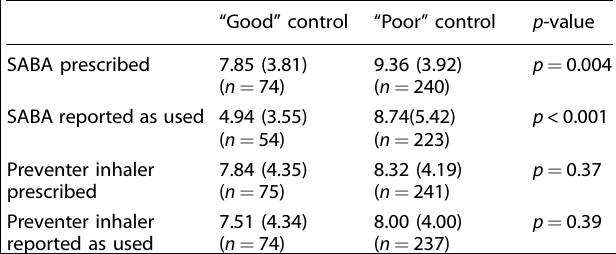
Table 3. Relationship between CGC de fi nition of asthma control and inhaler use.